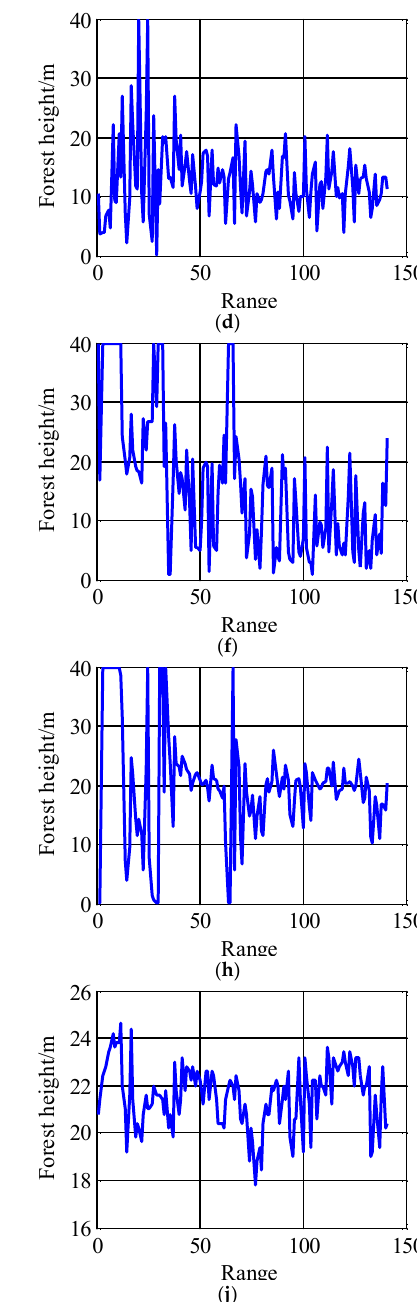
Figure 10. Forest height estimation results using measured X-band data, obtained using different methods. ( a , b ) are the results of NEPhVpd, ( c , d ) are the results of NEPcVpd, ( e , f ) are the results of NEPcVe, ( g , h ) are the results of EPcVpd, and ( i , j ) are the results of EPcVe, respectively. ( a , c , e , g , i ) are the two-dimensional height estimation results and ( b , d , f , h , j ) are the profiles of height along the range in the same azimuth